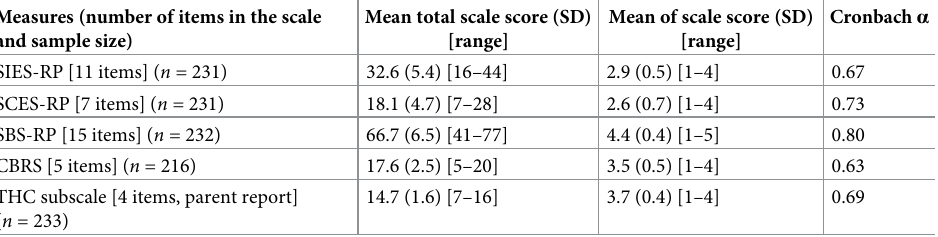
Table 3. School scale measures with mean scale score and reliability coefficients Cronbach α . Measures (number of items in the scale and sample